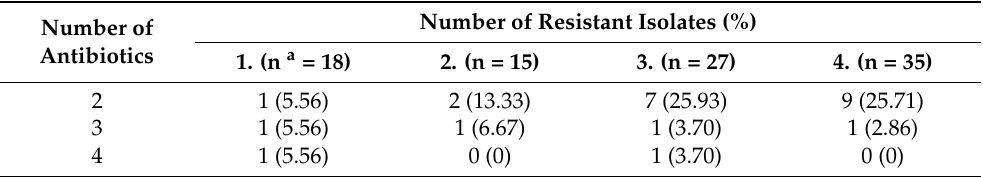
Table 2. The prevalence of multiresistant Acinetobacter isolates from the wastewater treatment plant Kokšov-Bakša (Košice, Slovakia).